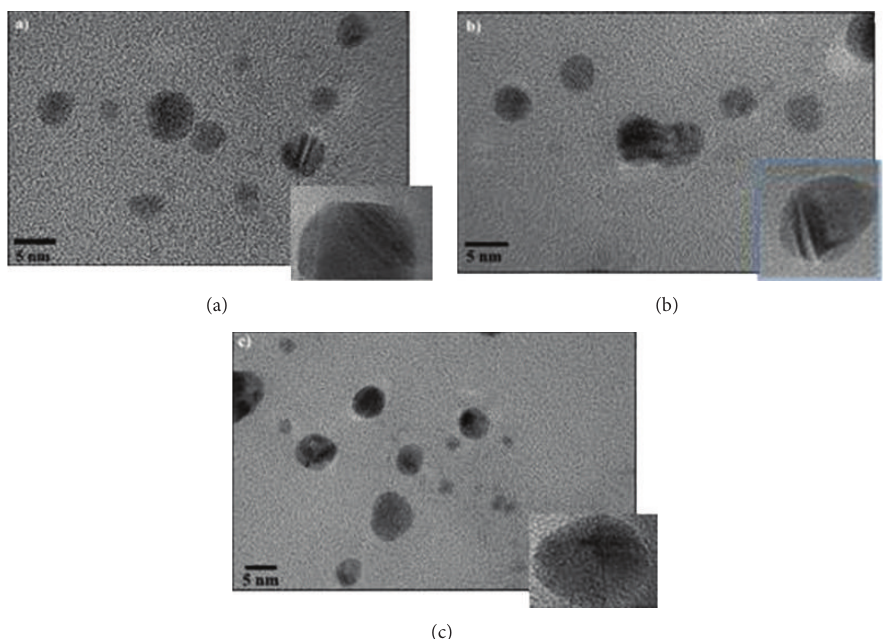
Figure 3: TEM image of silver nanoparticles biosynthesized by E. hermannii isolate SHE (a), C. sedlakii isolate S11P (b), and Ps. putida isolate S5 (c).